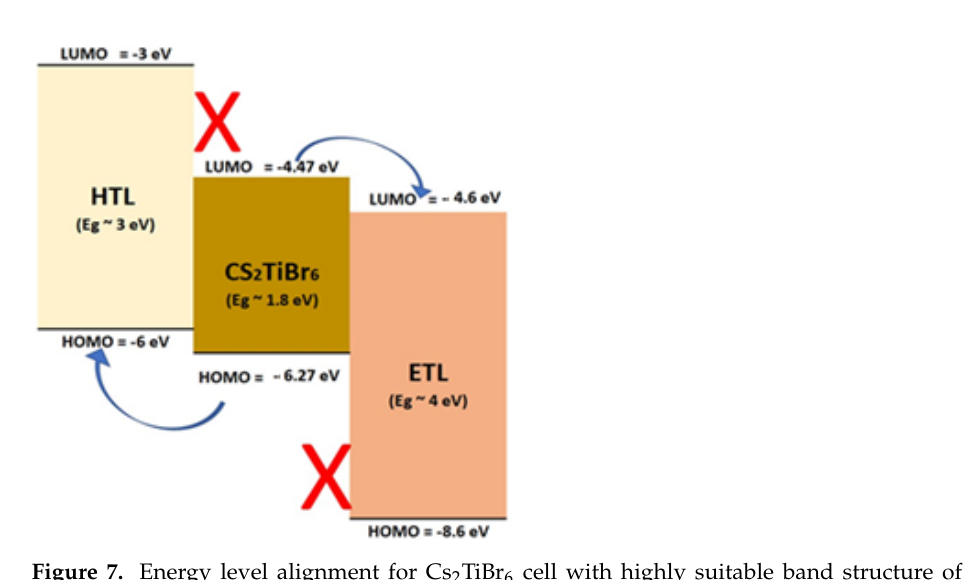
Figure 7. Energy level alignment for Cs 2 TiBr 6 cell with highly suitable band structure of hole transport and electron transport layer for an efficient photovoltaic response.